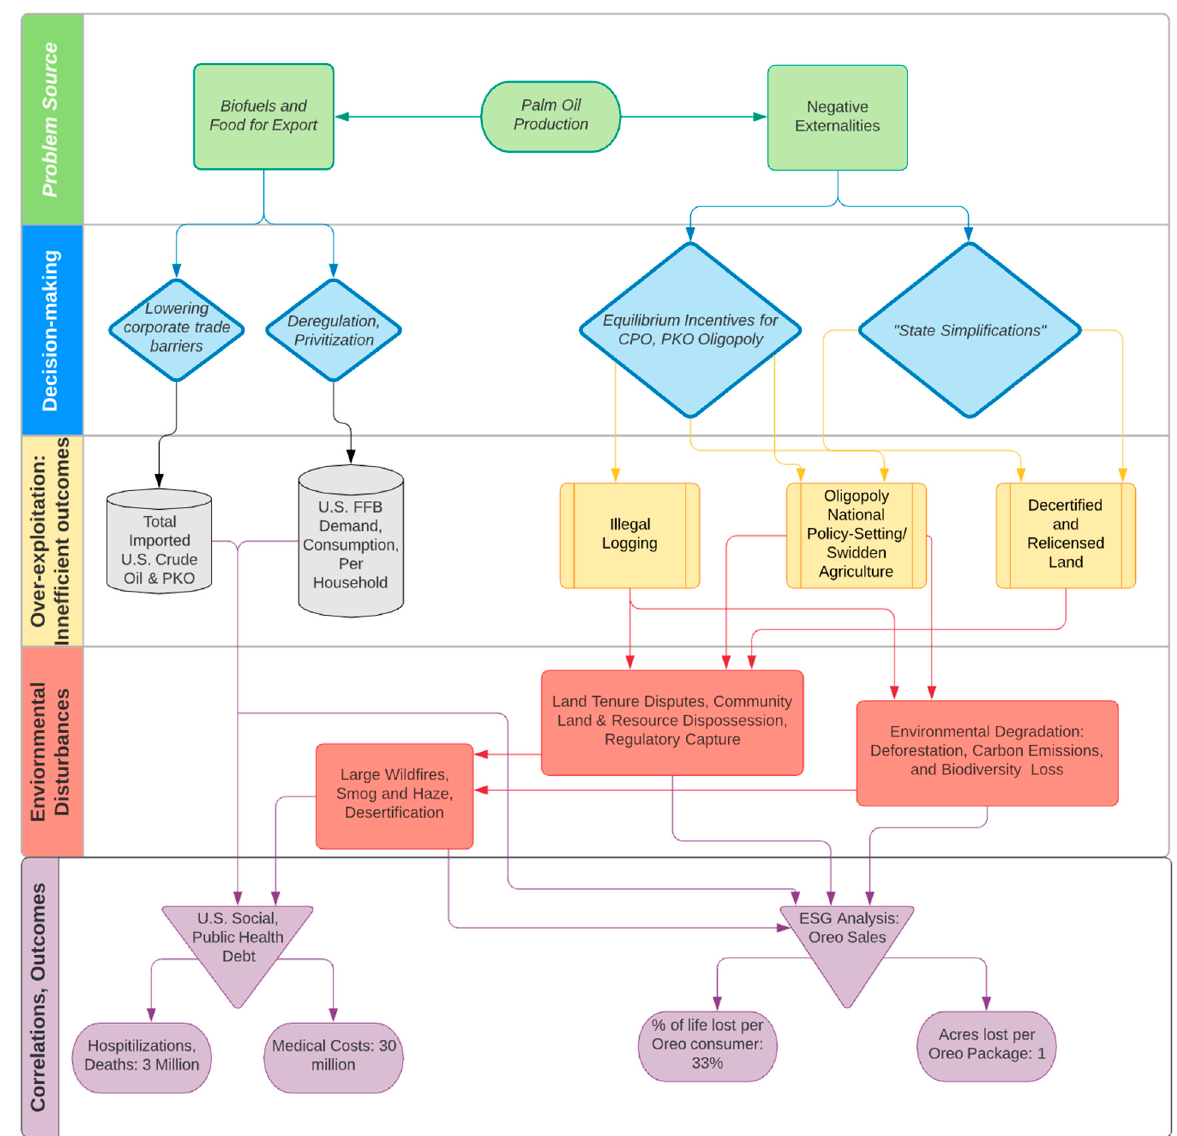
Figure 2. Relational Diagram Between Global Consumers and Palm Oil Externalities. Negative externality costs of production and consumption of palm oil diffuse rapidly as the intermediate good travels across national borders and dissipates into final goods, like snacks, detergents, and toothpaste. The perverse consequences of neoliberal, market-oriented reform policies, correlated with data on environmental disturbances and global food trade reports on Indonesia’s policy- and decision-making outcomes, have explicit political, social, and ecological dangers. Here, we disentangle the social and individual responsibility in consuming palm oil sourced goods, famous for instigating ecological degradation, social conflict, and economic inequality, to demonstrate the global consumption impact on the health and livelihood of disadvantaged communities across the tropics.